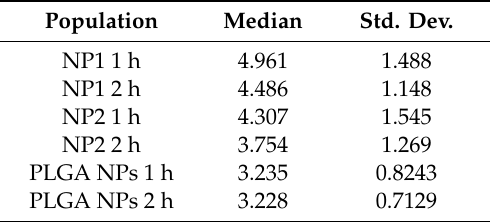
Table 2. Fluorescence internalization score (IS) measured by ImageStream ® X. The IS median values indicate the total amount of NP adsorbed by cells and are correlated to the hystograms reported in Figure 7B. Std. Dev. refers to standard deviation.